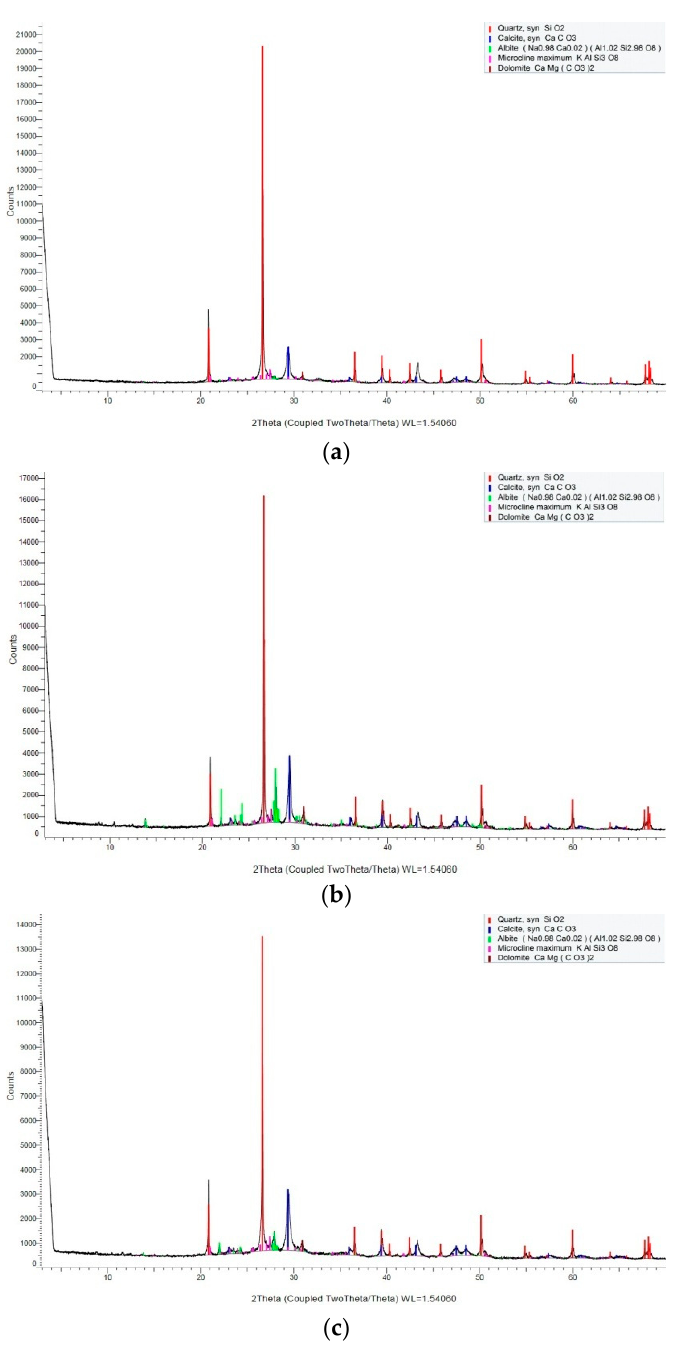
Figure 10. X-ray diffraction patterns of carbonation layers in different environments: ( a ) group AI (atmospheric environment), ( b ) group WB (water-immersion environment), and ( c ) group HA (saturated-humidity